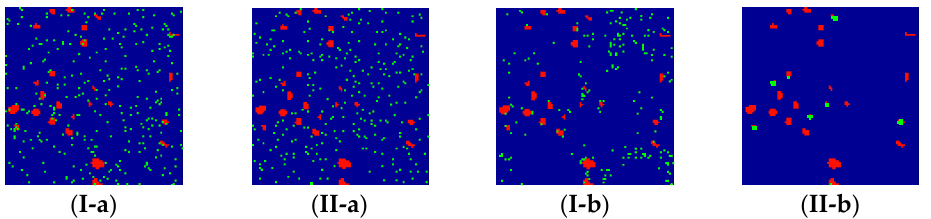
Figure 1. Visualization of chosen atoms in background and potential anomaly dictionaries for PAB- DC and the proposed method on the Los Angeles dataset. Here, green dots indicate chosen atoms in background and potential anomaly dictionaries, and the red areas represent the corresponding anomalies in the reference map. Note: ( I , II ) stand for the PAB-DC and the proposed method, respectively; ( a , b ) separately refer to the background dictionary and potential anomaly dictionary.